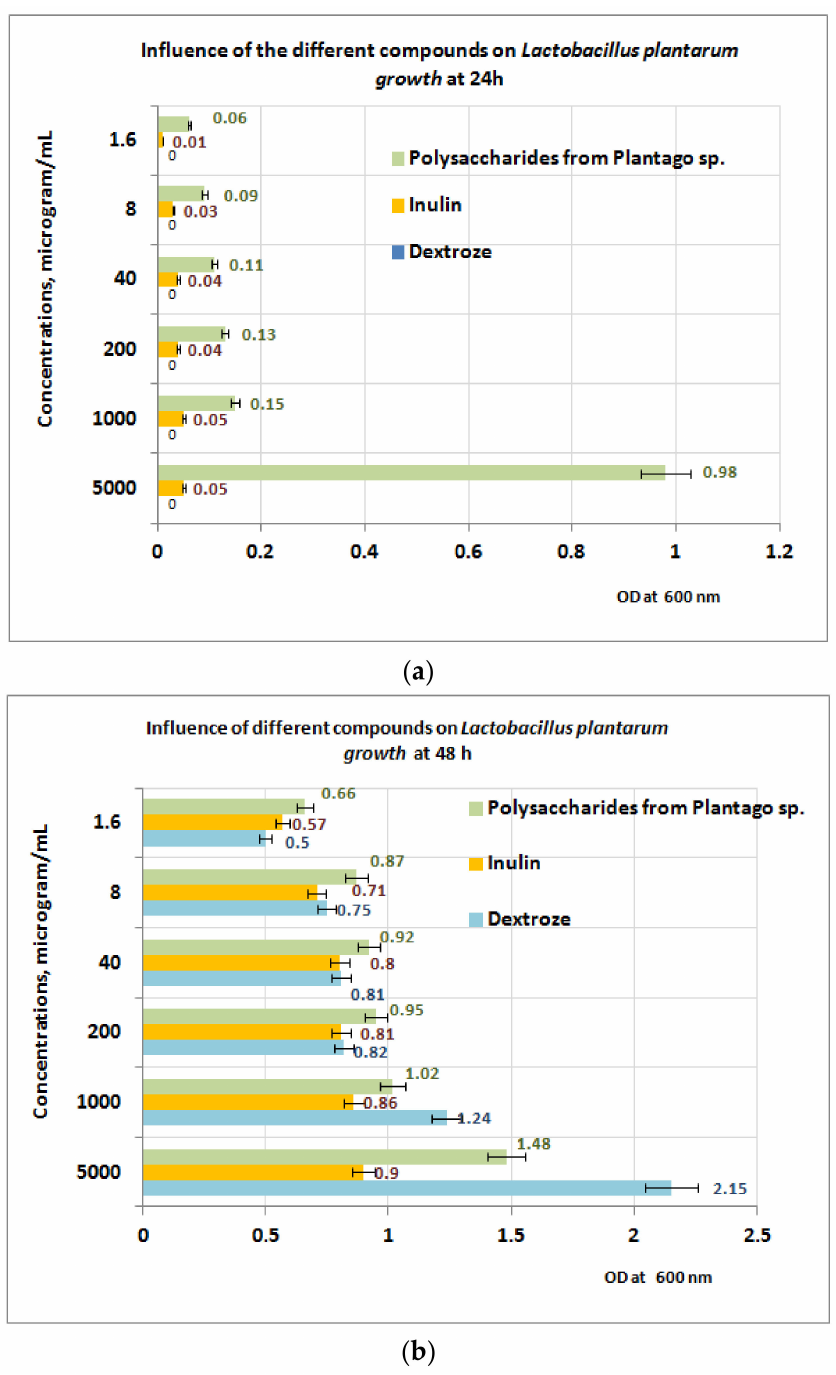
Figure 8. ( a ) Influence of PP on Lactobacillus plantarum growth at 24 h. ( b ) Influence of PP on L. plantarum growth at 48